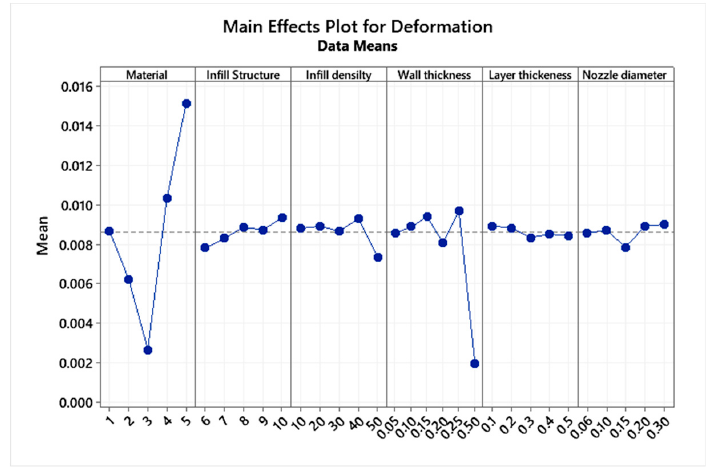
Figure 8. Main effects plot for stress .